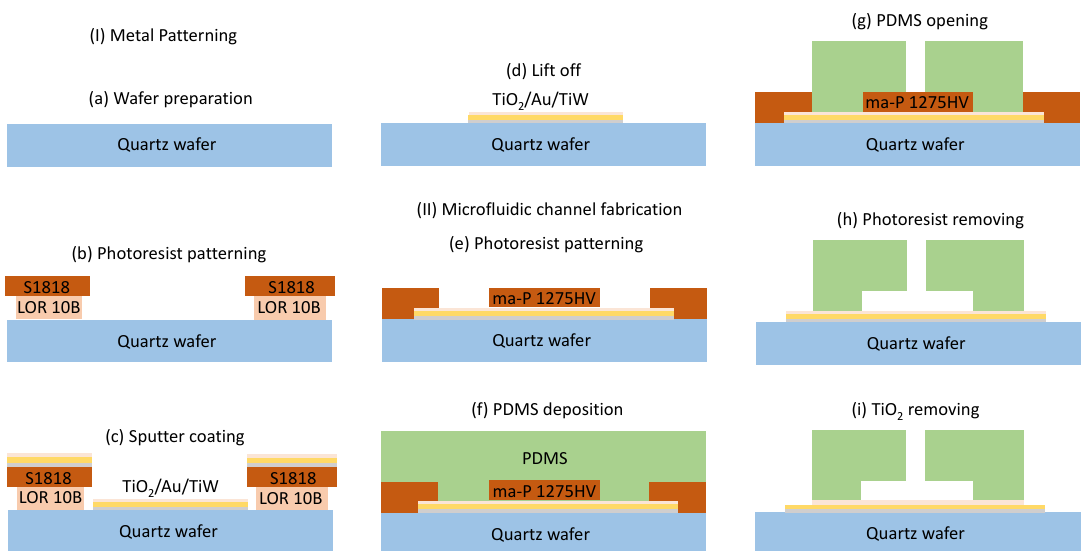
Figure 1. The proposed process to integrate microwave device and microfluidic channel. ( a ) Prepare the wafer for the process. ( b ) Pattern the double layer photoresis. ( c ) Sputter coat TiW, Au, and TiO 2 , successively. ( d ) Lift off in NMP. ( e ) Pattern sacrificial photoresist layer using the EVG620 automated mask aligner. ( f ) Deposit and cure polydimethylsiloxane (PDMS) on the whole wafer. ( g ) Punch liquid access hole with a biomedical perforator and remove unwanted PDMS with a micro scalpel. ( h ) Soak the wafer in acetone to remove the sacrificial photoresist layer. ( i ) Remove TiO 2 not covered by PDMS layer using